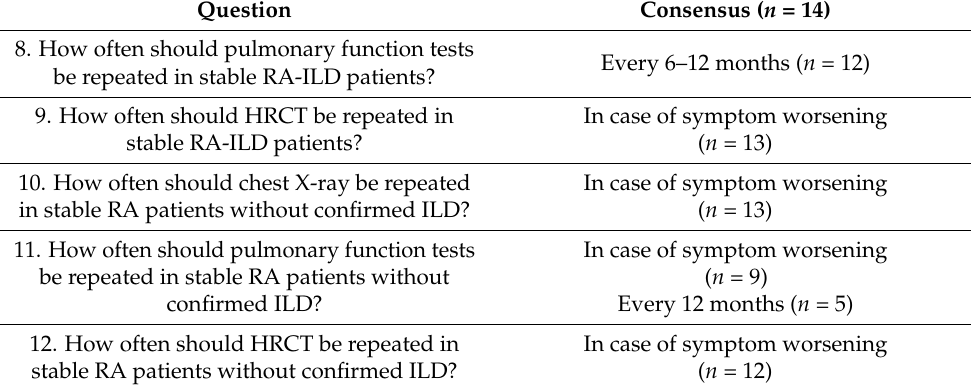
Table 3. Cont. Question Consensus ( n = 14)